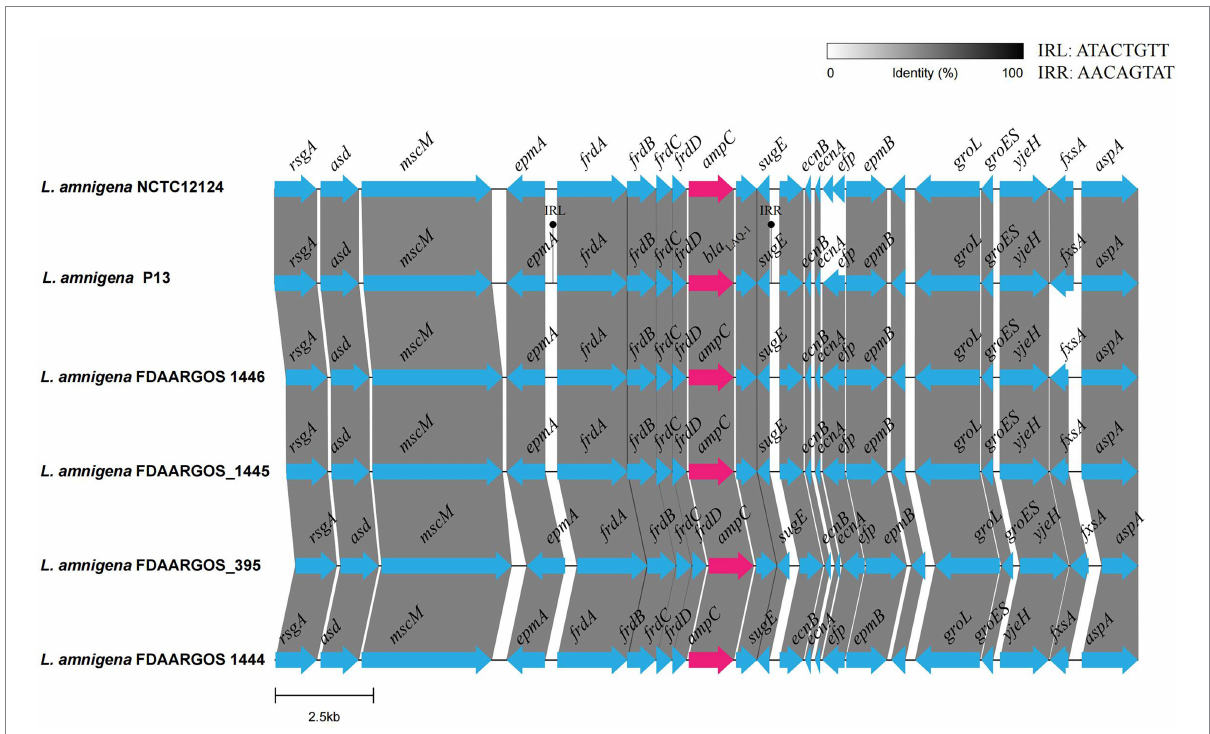
FIGURE 4 Comparative genomic analysis of the genetic context of bla LAQ-1 with the sequences carrying their homologous genes. The direction of genes is shown via an arrow. The bla LAQ-1 gene and putative ampC ( bla LAQ-1 -like) genes are colored red, and the other genes are colored blue. The predicted hypothetical genes are in gray. The sequences and their accession numbers are as follows: L. amnigena NCTC12124 (LR134135.1), L. amnigena FDAARGOS 1446 (CP077331.1), L. amnigena FDAARGOS_1445 (CP079896.1), L. amnigena FDAARGOS 1444 (CP077236.1) and L. amnigena FDAARGOS 395